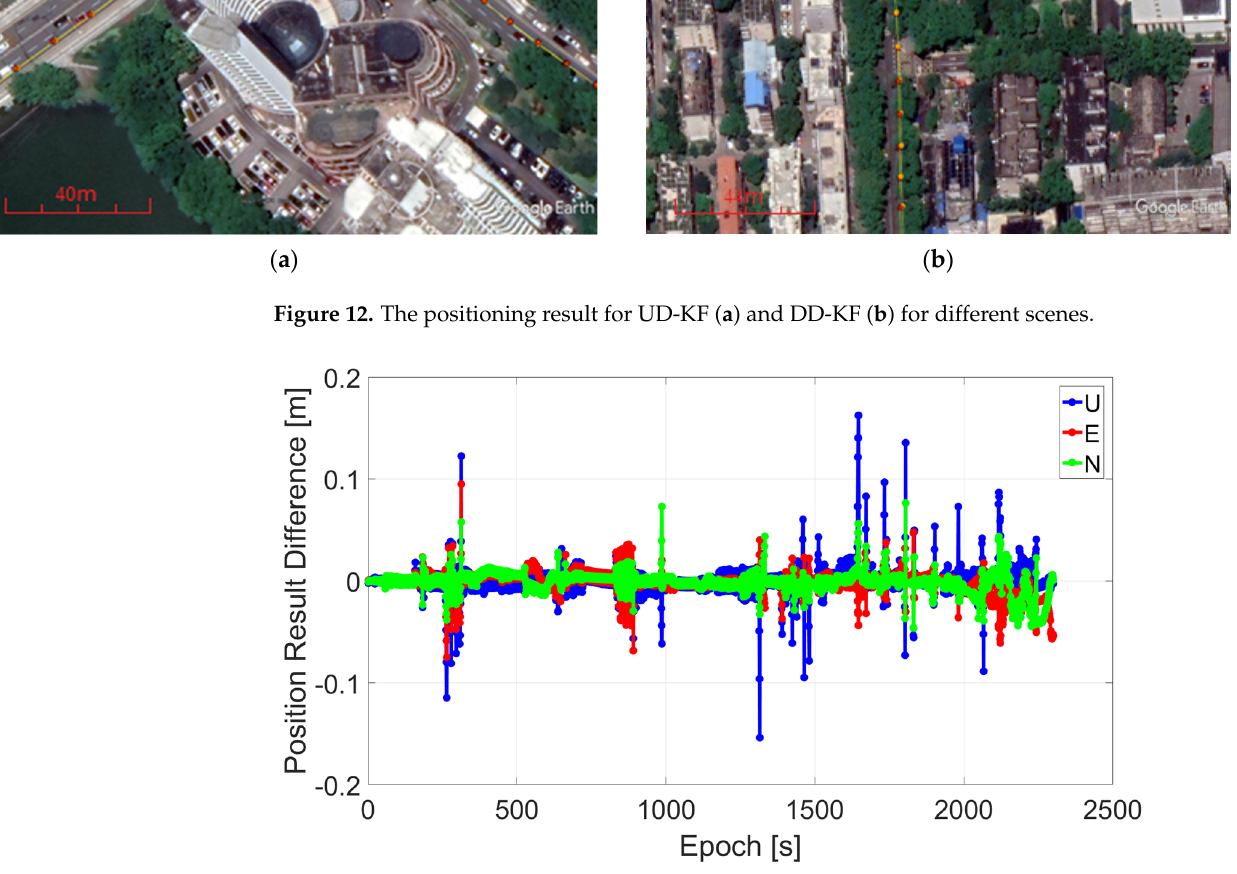
Figure 14. Filter and fix time difference and the corresponding satellite number.